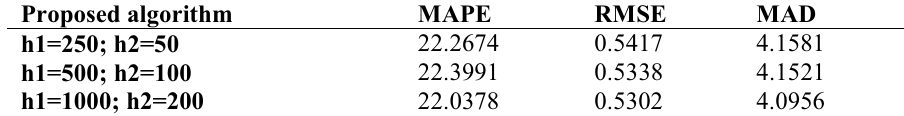
Table 6. MAPE, RMSE and MAD values of various hidden layers in proposed technique for dataset Proposed algorithm